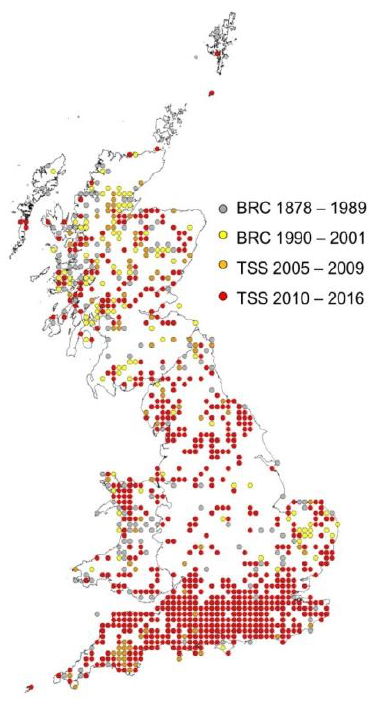
Figure 5. Distribution of Ixodes ricinus ticks in Great Britain (after [79]).